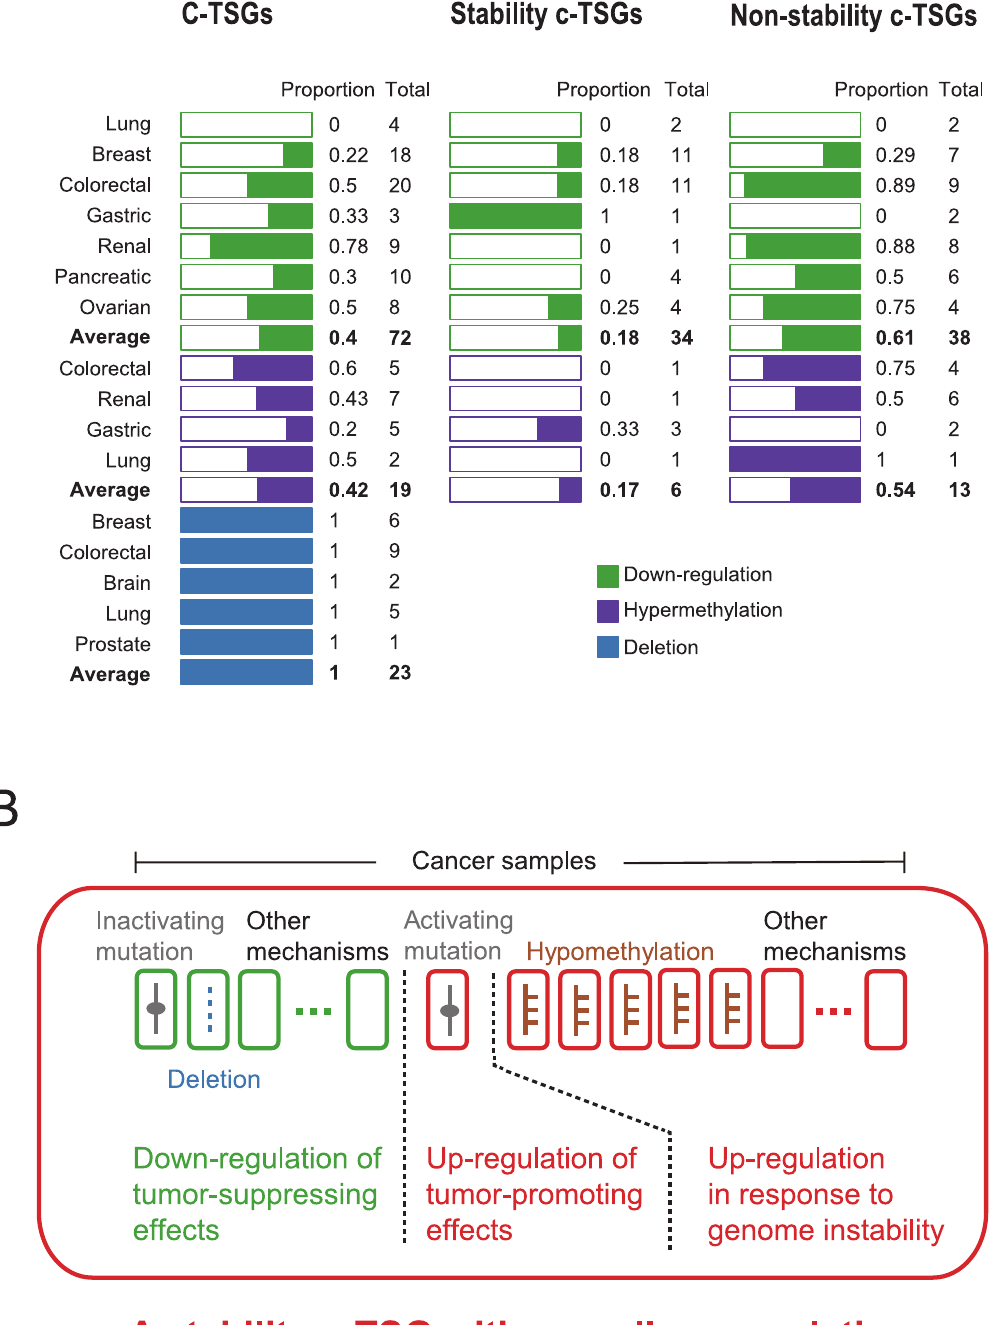
Figure 2. The expression, methylation and copy number changes of C-TSGs and the related mechanisms. A , Numbers of C-TSGs, including stability C-TSGs and non-stability C-TSGs, with expression, methylation and copy number changes in the corresponding cancer types. A full list of these C-TSGs is given in Table S4. B , The mechanisms underlying the overall up-regulation of stability C-TSGs in cancer patient population.